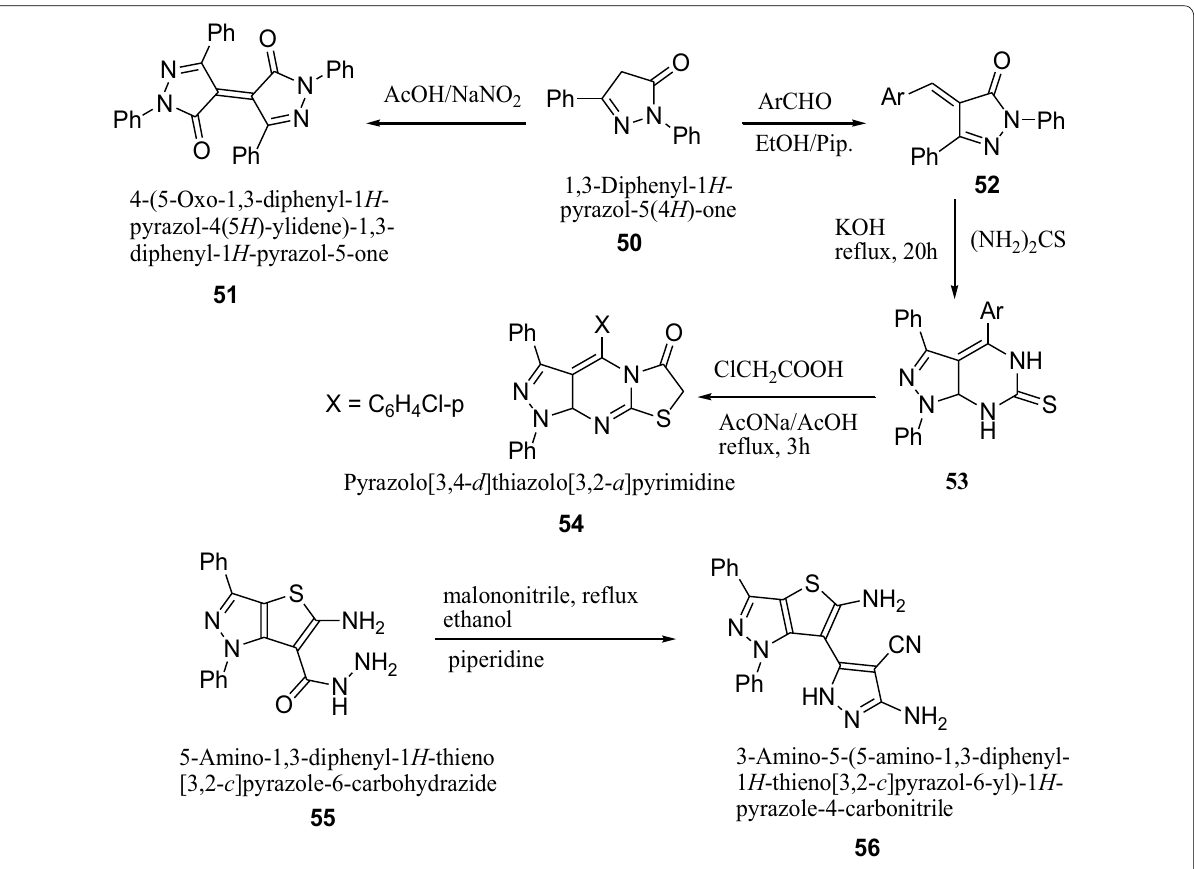
Table 12 Antibacterial and antifungal activities of compound as MIC values (μg/ml) Compounds Bacterial species Inhibition zone diameter (mm)